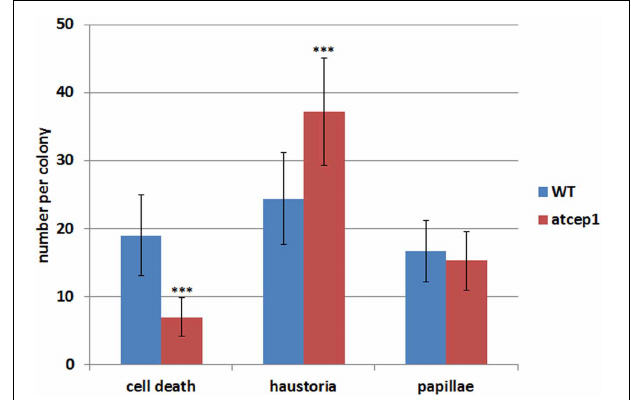
FIGURE 8 | The epidermal cell death is suppressed in cells attacked by Erysiphe cruciferarum on the atcep1 mutant 5 dpi compared to the WT. Columns show the frequency per colony of epidermal cell death, haustoria and papilla in cells attacked by E. cruciferarum . Data present the mean of 54 colonies on three leaves per wild type and atcep1 mutant line, respectively. Error bars are standard deviations. Differences between wild type and atcep1 are highly significant after two sided student’s t -test p < 0 . 001 ( ∗∗∗ ). The results were similarly reproduced in a second independent inoculation with 48 colonies on three leaves per WT and atcep1 mutant line,